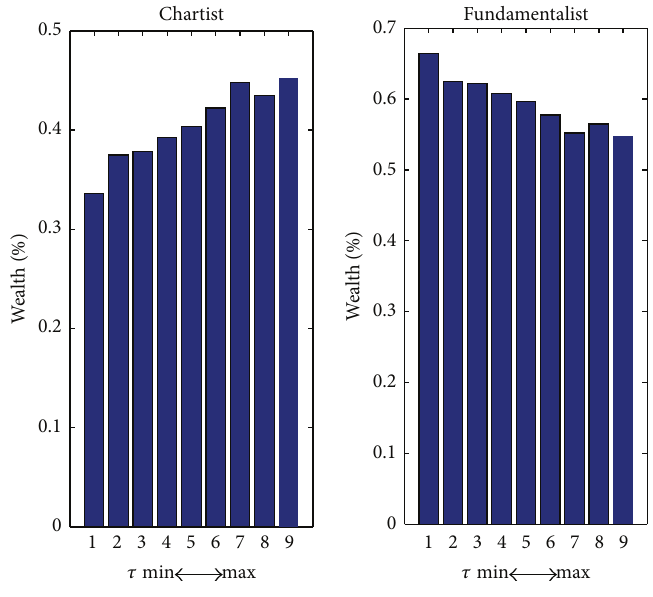
Figure 7: Wealth shares (𝑑 𝑓 ∈ (0.5, 0.6))